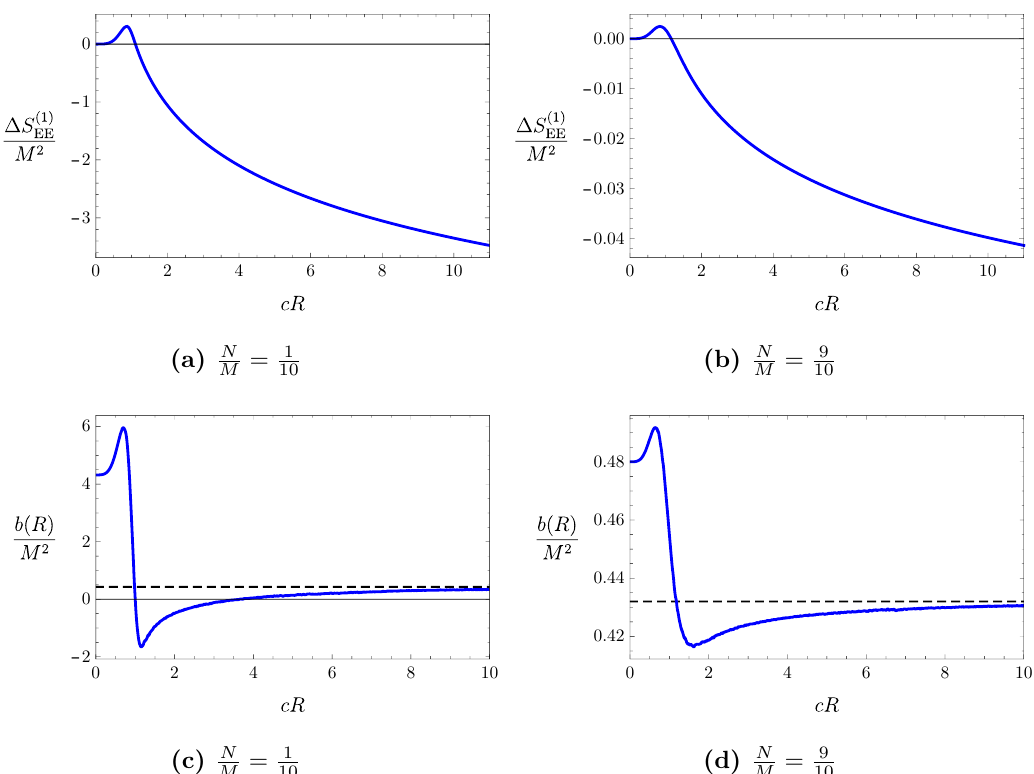
Figure 3. Numerical results for the entanglement entropy (top row) and b -function (bottom row) de(cid:12)ned in (1.4), for the defect RG (cid:13)ow from a bundle of N M2-branes in the UV to the antisymmetric Wilson surface in the IR. For small values of cR , the b -function is given by the ( M (cid:0) N ) times the central charge for a single M2-brane (3.12). As cR ! 1 , the b -function tends to the central charge of the antisymmetric Wilson surface (4.17), indicated by the horizontal dashed lines in the plots. For cR ! 0, the b -function tends to the central charge of the UV solution, namely N times the central charge for a single M2-brane (3.12), b ( R = 0) (cid:17) b